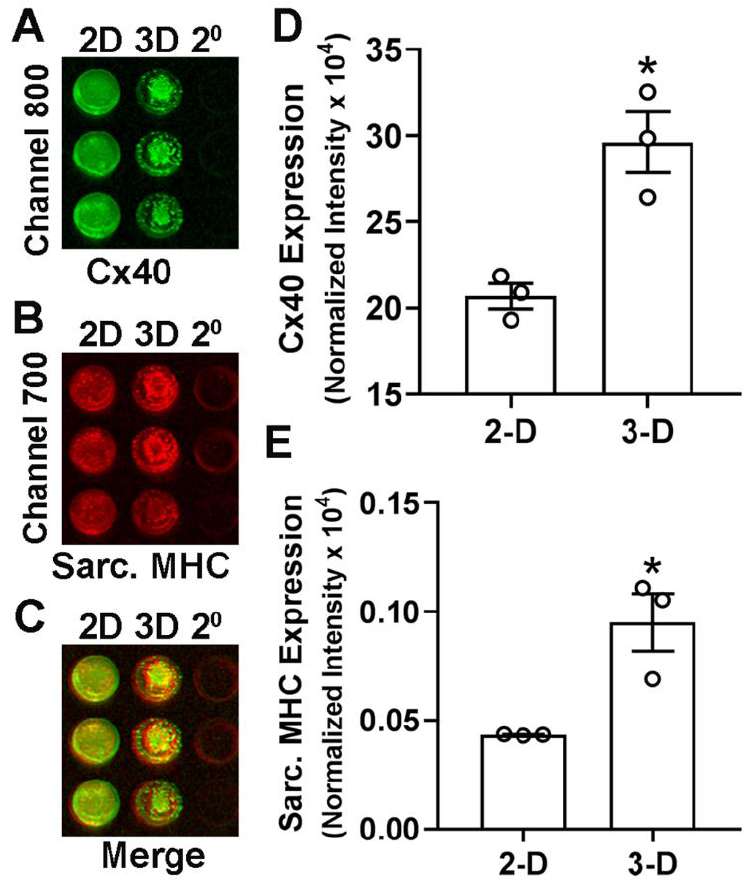
Figure 4. Analysis of Cx40 and sarcomeric myosin (sarc. MHC) expression levels by In-Cell western blotting technique. ( A – C ) E11.5 ventricular cells cultured in 2-D or 3-D conditions for 8 days were incubated with primary antibodies specific for Cx40 and sarc. MHC and signals were visualized with anti-rabbit (( A ), 800 channel, Cx40) and anti-mouse (( D ), 700 channel, sarc. MHC) secondary DyLight conjugated antibodies. Panel C represents merged signals from both channels shown in panels A and B. Last columns in panels A-C represent 3-D cultures stained with only secondary antibodies (2 ◦ ) and omitting the primary antibodies. ( D , E ) Quantification of Cx40 and sarcomeric myosin heavy chain (sarc. MHC) expression levels in 2-D and 3-D cultures of E11.5 ventricular cells. Expression levels were normalized to cell number/DNA content in all wells. Each bar represents mean ± SEM. Open circles represent individual data points for each group. * p < 0.05 for 2-D vs. 3-D, Student’s unpaired t